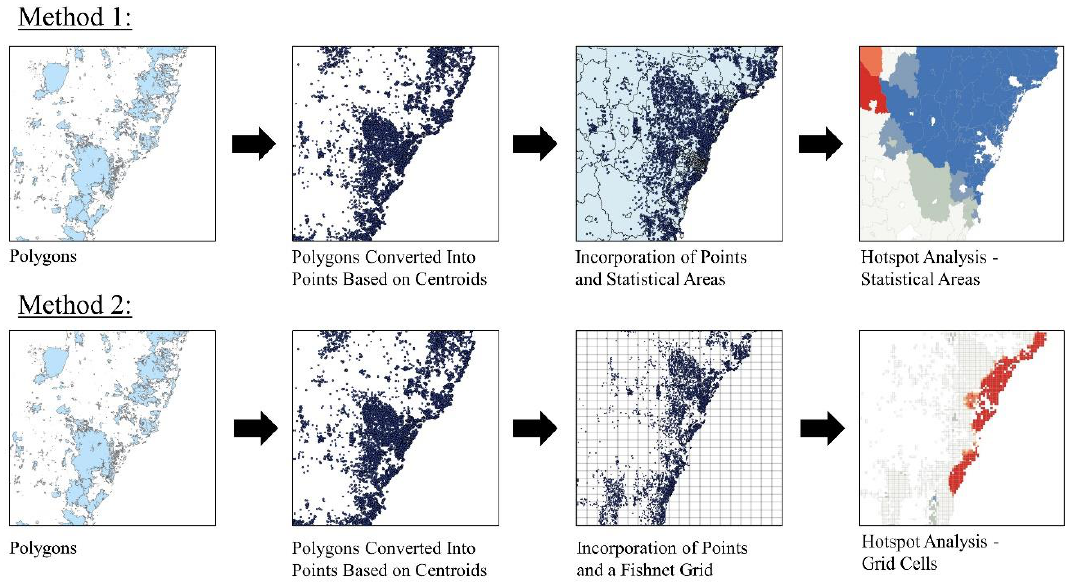
Figure 5. Hotspot methodologies.